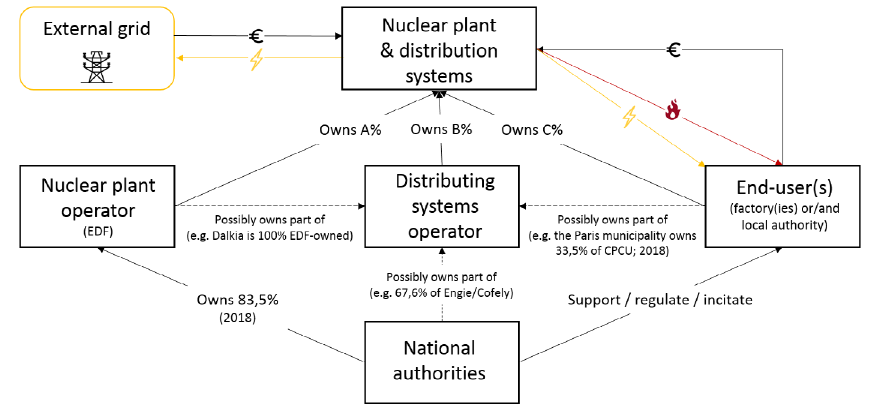
Figure 3. Organisation chart of a Mankala energy